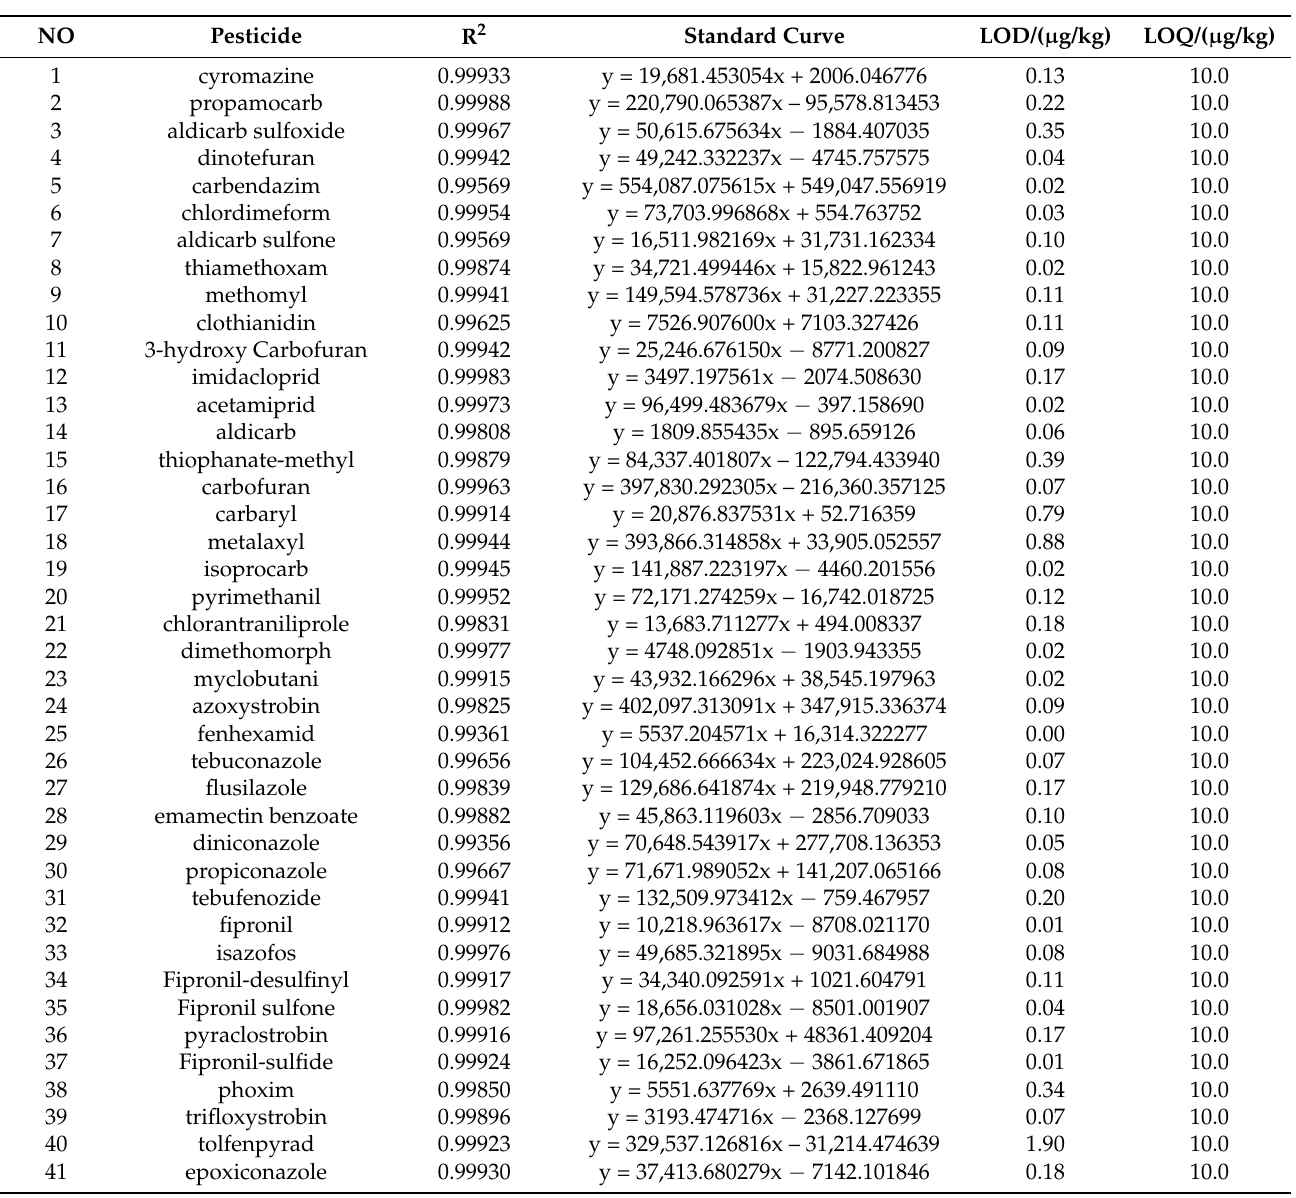
Table 3. Evaluation of the performance of leek sample treatment procedures in terms of coefficient of determination, standard curve, LOD and